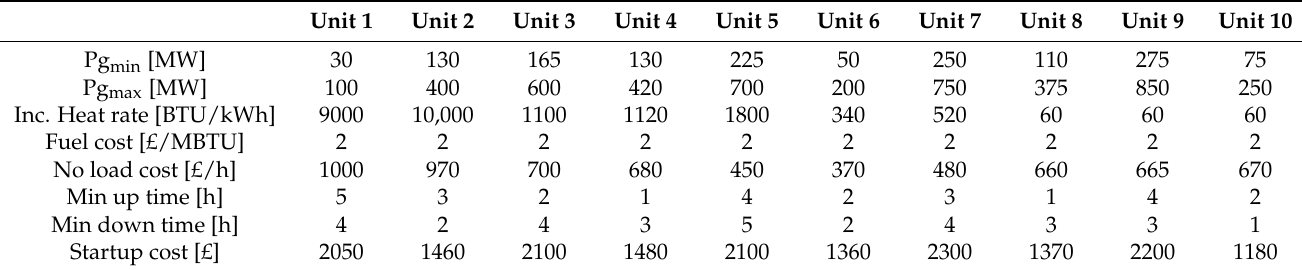
Table 4. Case 2—test system